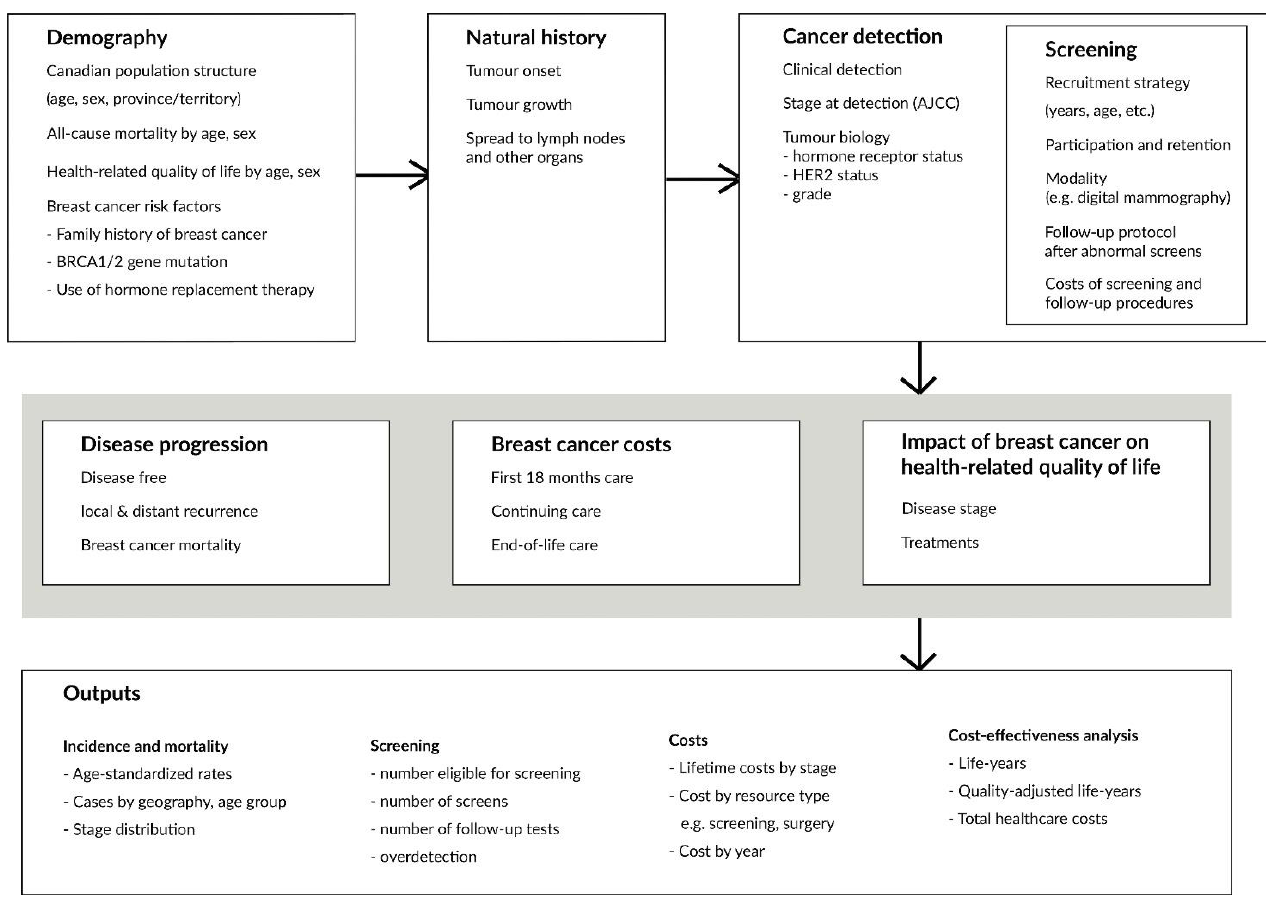
Figure 2. Model inputs and outputs. Table 1. Model inputs data sources.